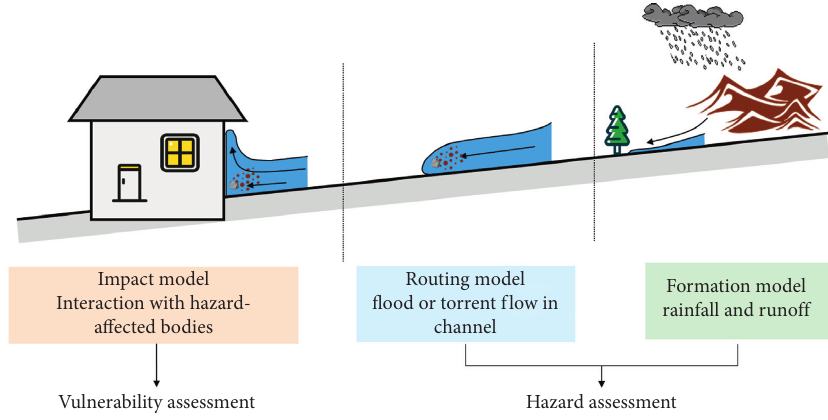
Figure 1: Flood risk